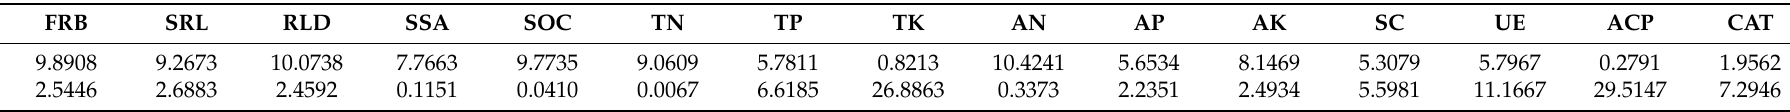
Table 3. Principal component analysis contribution rate of